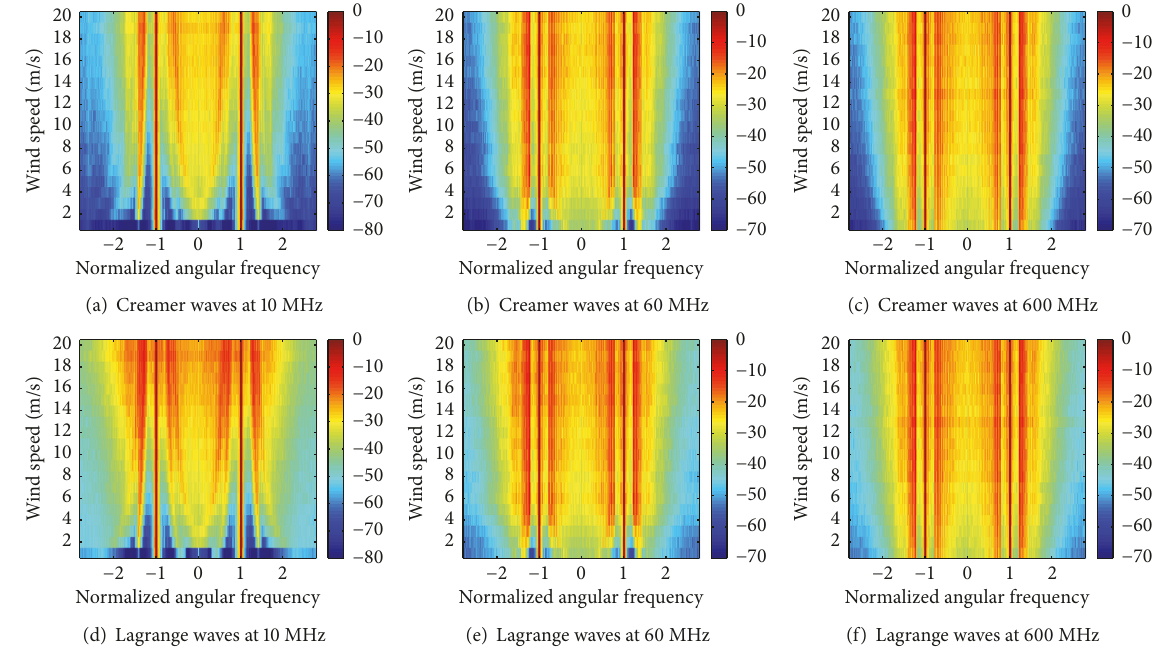
Figure 11: Doppler spectrum of nonlinear waves in different sea states and different operating frequencies. The horizontal axis represents the Doppler frequency normalized by the Bragg frequency 𝜔 𝑏 , the vertical axis is the wind speed at 10 meters above sea level, and the color depth represents Doppler spectrum intensity.